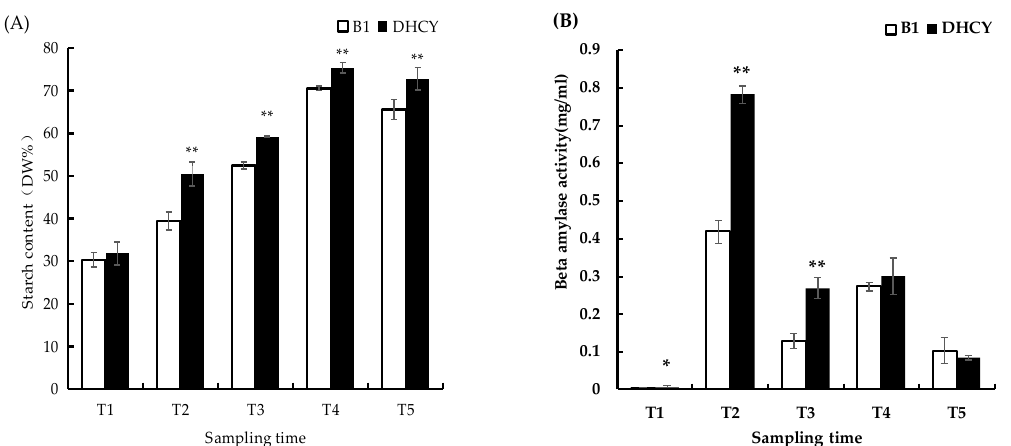
Figure 1. Changes in ( A ) starch content and ( B ) β-amylase activity in yam tubers. * and ** indicate a significant difference between the DHCY and B1 at p <0.05 and p < 0.01, respectively.